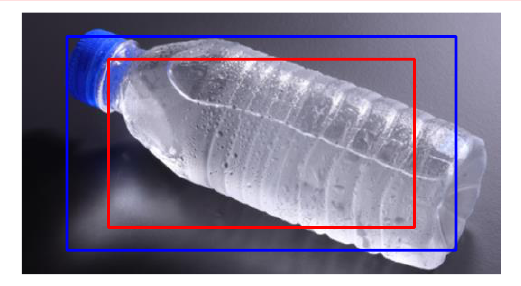
Figure 4. A CIoU problem related to two possible predicted boxes (in red color) corresponding to the same ground truth box (in blue color).